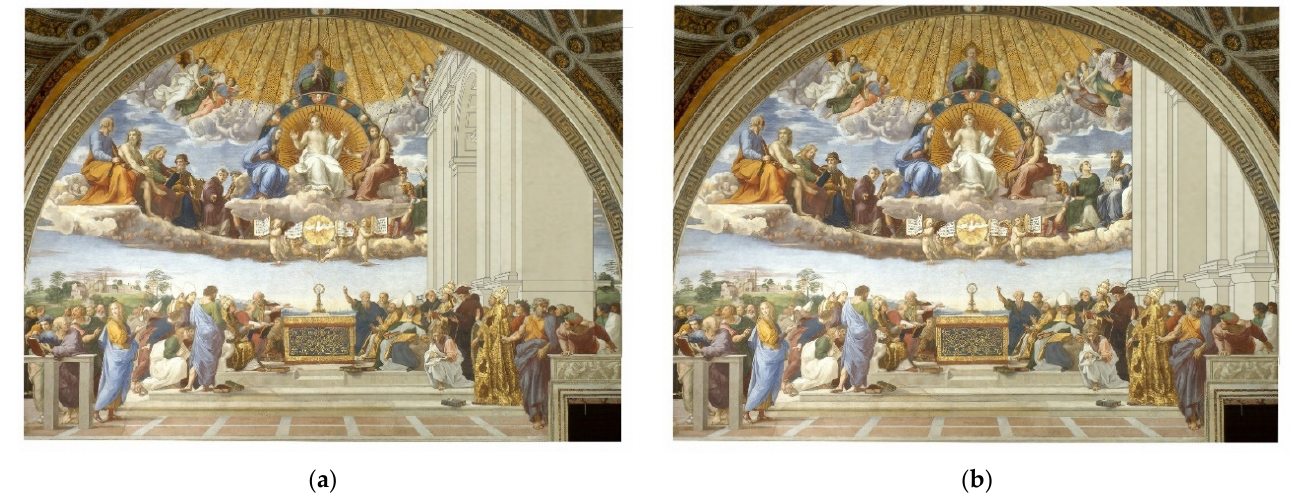
Figure 17. Digital Photomontage of the Triumphal Arch in Raffaello’s The Disputa , considering the stone block as the right pillar ( a ) or the left pillar ( b ).